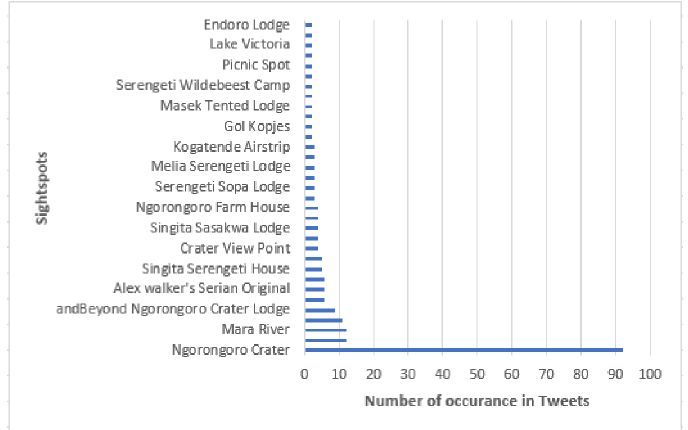
Figure 15. POI discovered.